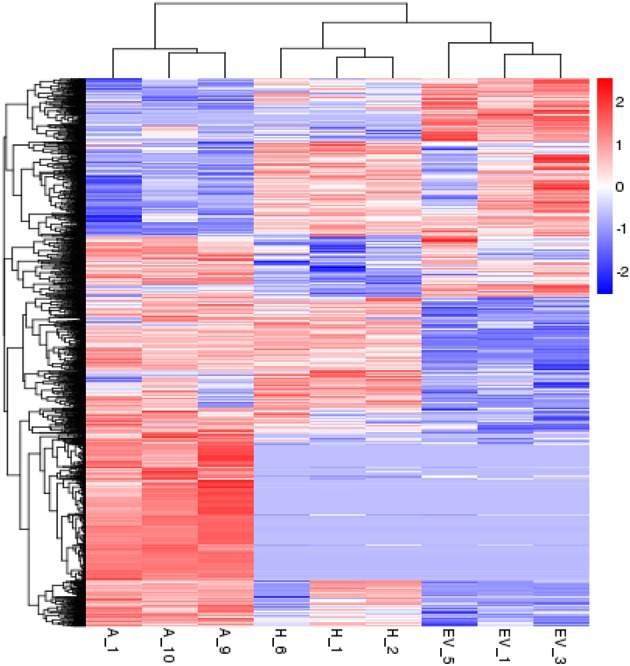
Hierarchical clustering of the differentially expressed genes, using the RNA-seq data derived from three groups (A: AANAT, H: HIOMT, and EV: empty vector, hereafter) based on log10 RPKM values.